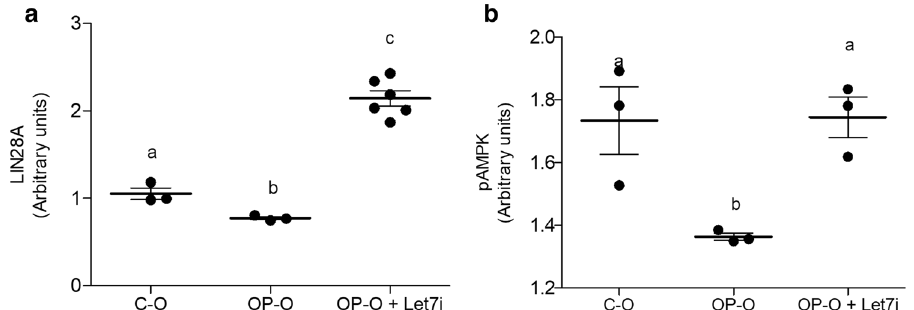
Figure 4. Ex-vivo manipulation of hepatic Let-7a rescues pAMPKα2 levels. LIN28A (a) and pAMPKα2 (b) levels of ex-vivo liver transfection of newborn male offspring with Let-7 a inhibitor (10 nM) for 24 h by indirect ELISA. One-way ANOVA were used in the analysis to compare all groups. Values are means (n = 3–6/group) with their standard errors represented by vertical bars. Bonferroni post-hoc test was used to determine a significance level of p ≤ 0.05. Different letters indicate statistical significance between